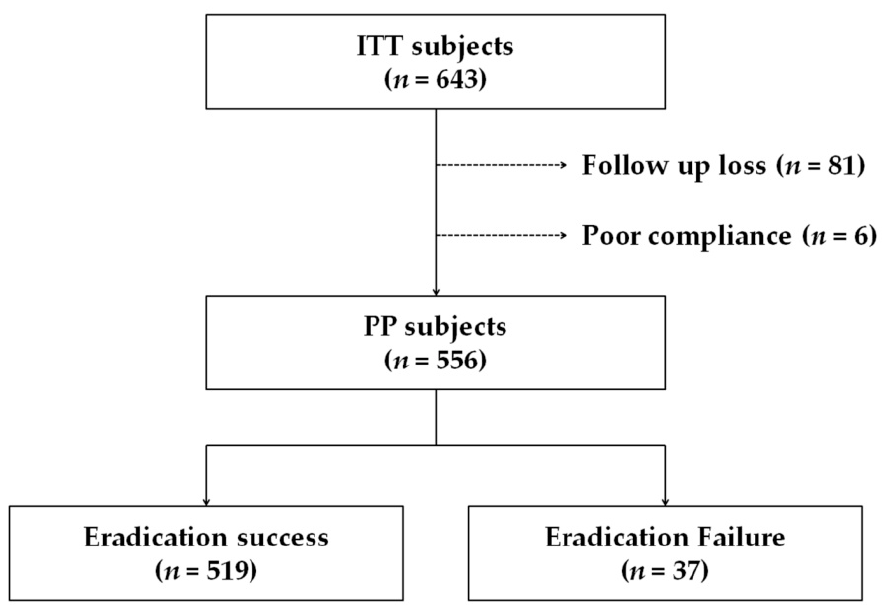
Figure 1. Flowchart of the study. ITT, intention-to-treat; PP, per-protocol. Table 1. Baseline characteristics of patients.